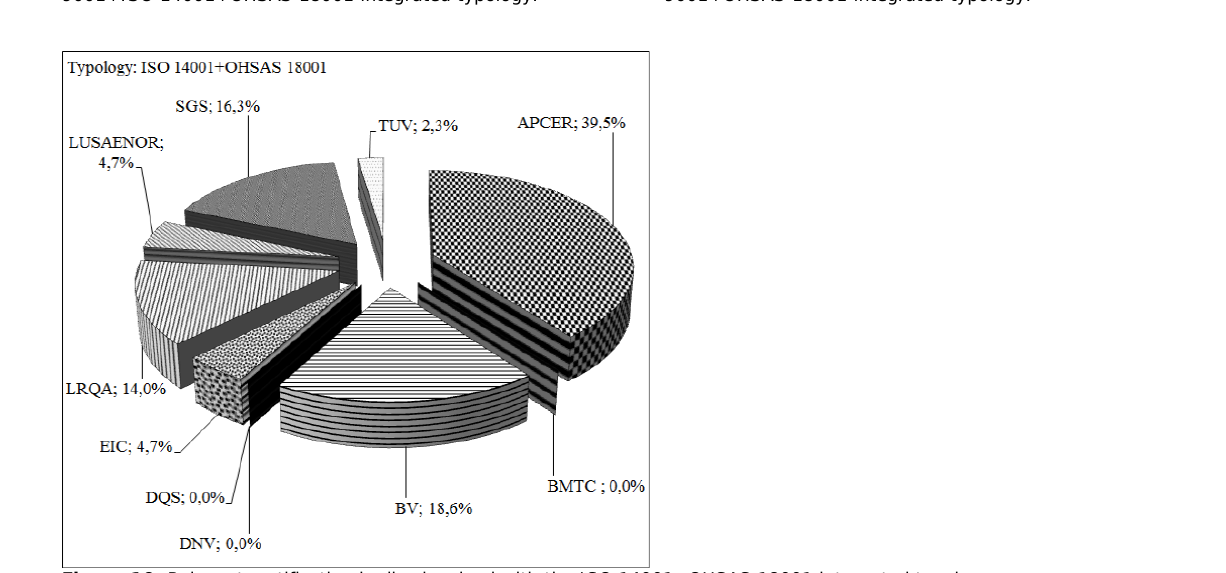
Figure 8. Relevant certification bodies involved with the ISO 9001+ISO 14001+OHSAS 18001 integrated typology.